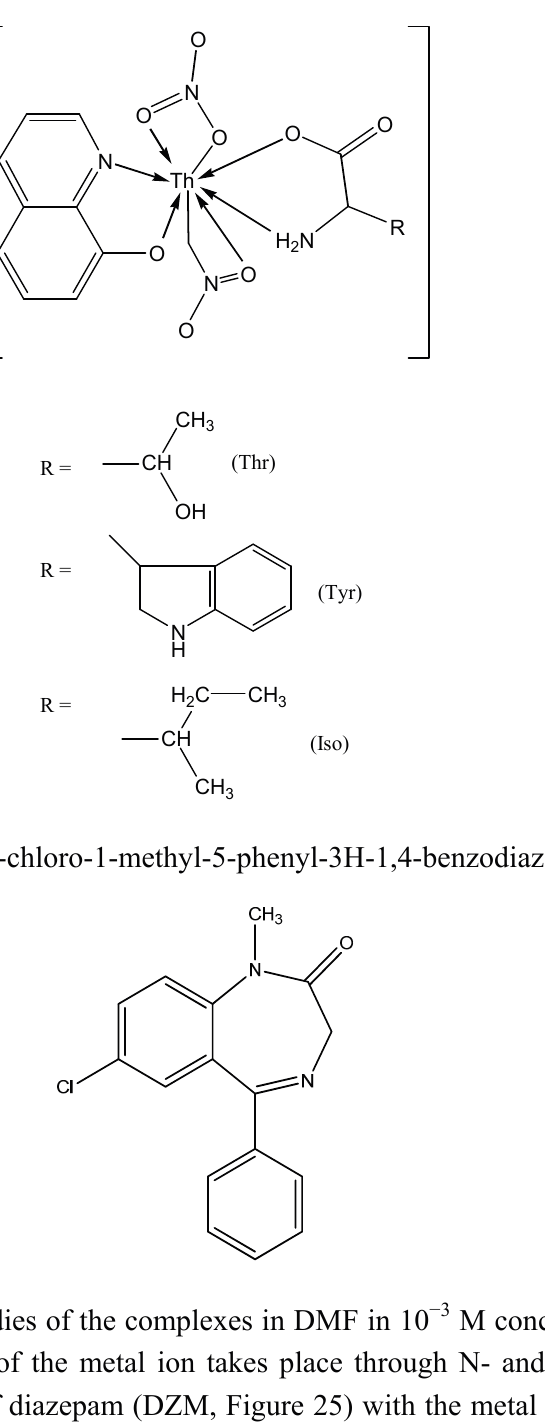
Figure 24. Proposed structures and bonding for the 8-hydroxyquinoline complexes.